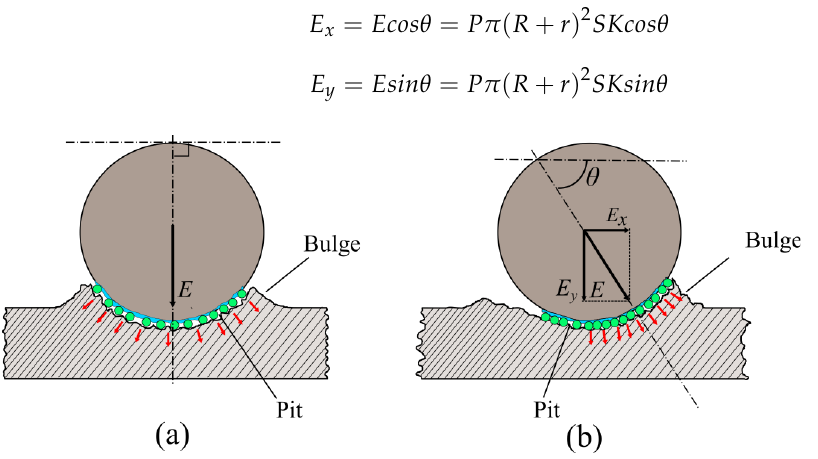
Figure 14. ( a ) Schematic view of the effect of jet pressure on pits; ( b ) Schematic view of the effect of jet angle on pits.